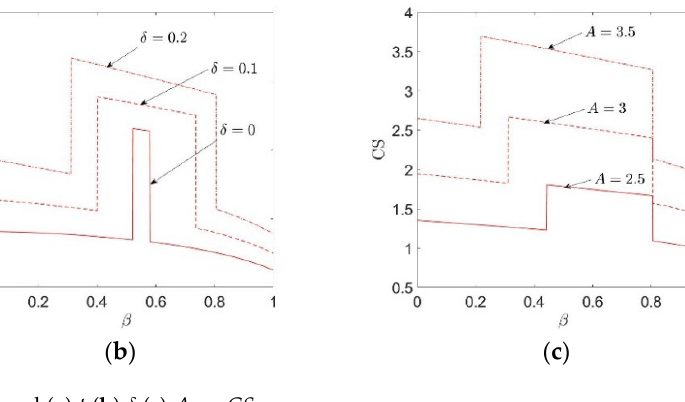
( c ) Figure 8. Impacts of 𝛽𝛽 and ( a ) 𝑡𝑡 ( b ) 𝛿𝛿 ( c ) 𝐴𝐴 on SW. 6. Theoretical Contributions This research contributes to the existing literature in three aspects. First, this paper contributes to the research of coopetition in supply chain manage- ment by incorporating horizontal green technology licensing strategies into the quantity and product greenness competition models. In existing research, coopetition between supply chain members mainly refers to outsourcing decisions in supply chains [7,8], stra- tegic alliance formation [9,10], or coopetitive investments in quality or product greenness [11–13]. However, the notion that green technology licensing as a coopetative strategy between brown and green firms is seldom studied the existing literature. Therefore, this paper contributes to the theory of coopetition in supply chains. In the model analysis, we have highlighted the economical and environmental impacts of such coopetition. Second, this paper has enriched the existing literature on technology licensing by considering the greenness property of the technology. In previous literature, researchers have considered various factors in technology licensing, such as product differentiation between licensors and licensees [25], multiple competition firms [25], imitation behaviours of technology [28], innovation degree of the technology [29], etc. However, none of them have realized the importance of factor of technology’s green property. This paper fills this gap and has established new technology licensing models to study the new technology licensing problem. Additionally, some interesting and meaningful results concerning the technology’s green property are also provided. These results not only contribute to firms’ economic benefits (which is the focus of the existing literature), but also contribute to wel- fare implications (which provides important implications to the consumers and the gov- ernments). Last, this paper has investigated how green technology licensing affect the selling strategies under competition. In the existing literature on green product selling, investing